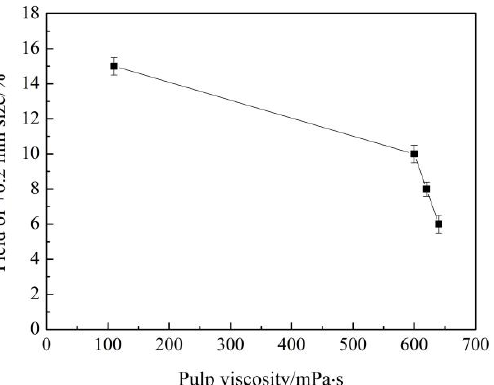
Figure 4. The relationship between pulp viscosity and the 0.2 mm size fraction yield.